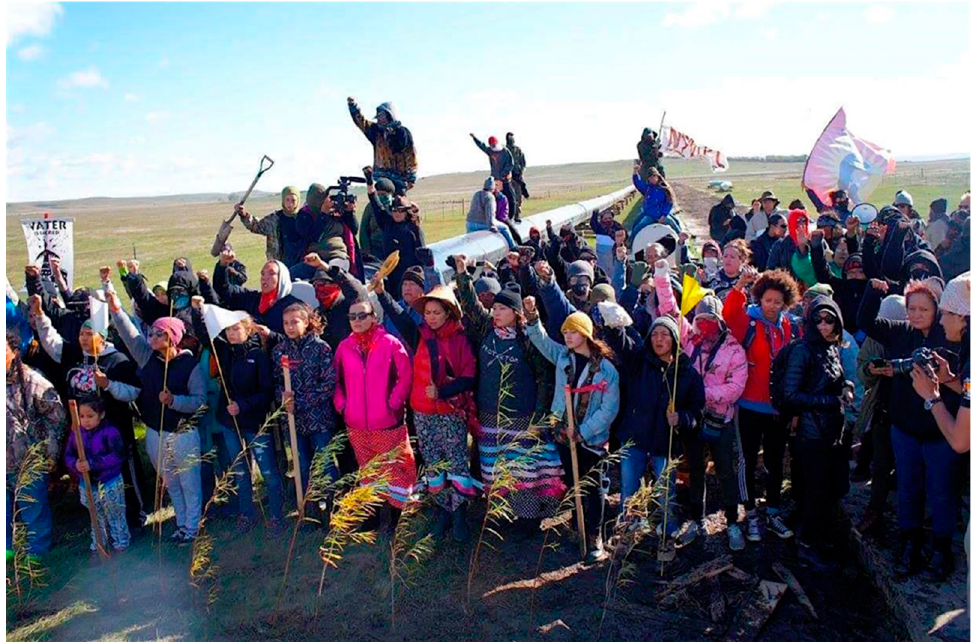
Figure 1. Women at the Dakota Access Pipeline (Photo by Bethany Yellowtail in Lane 2018).